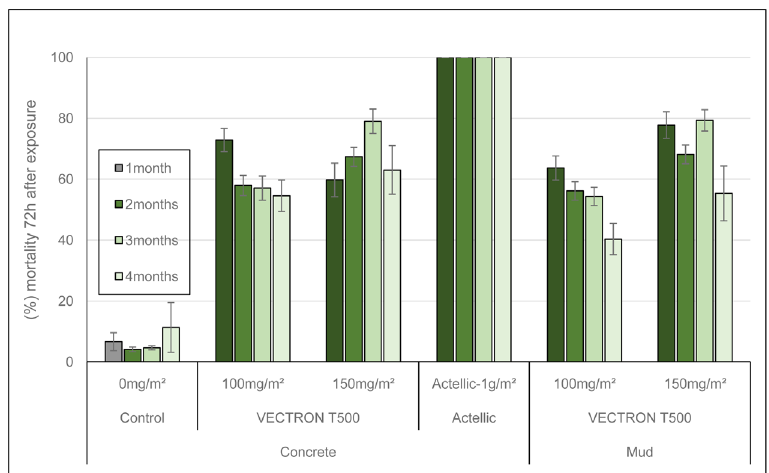
Figure 3. Overall mortality per month of wild free-flying pyrethroid-resistant Anopheles gambiae s.l. collected daily inside treated huts for 4 months evaluation. Each histogram represents monthly mean mortality rate of mosquitoes collected inside each hut during the month and error bars represent ± 95% confidence interval (CI).